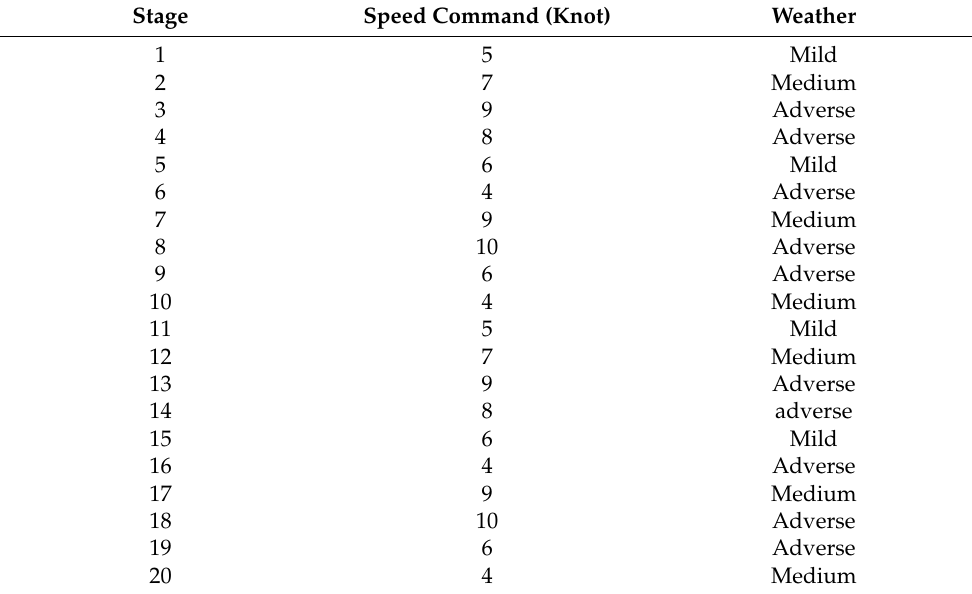
Table 3. Weather condition at voyage